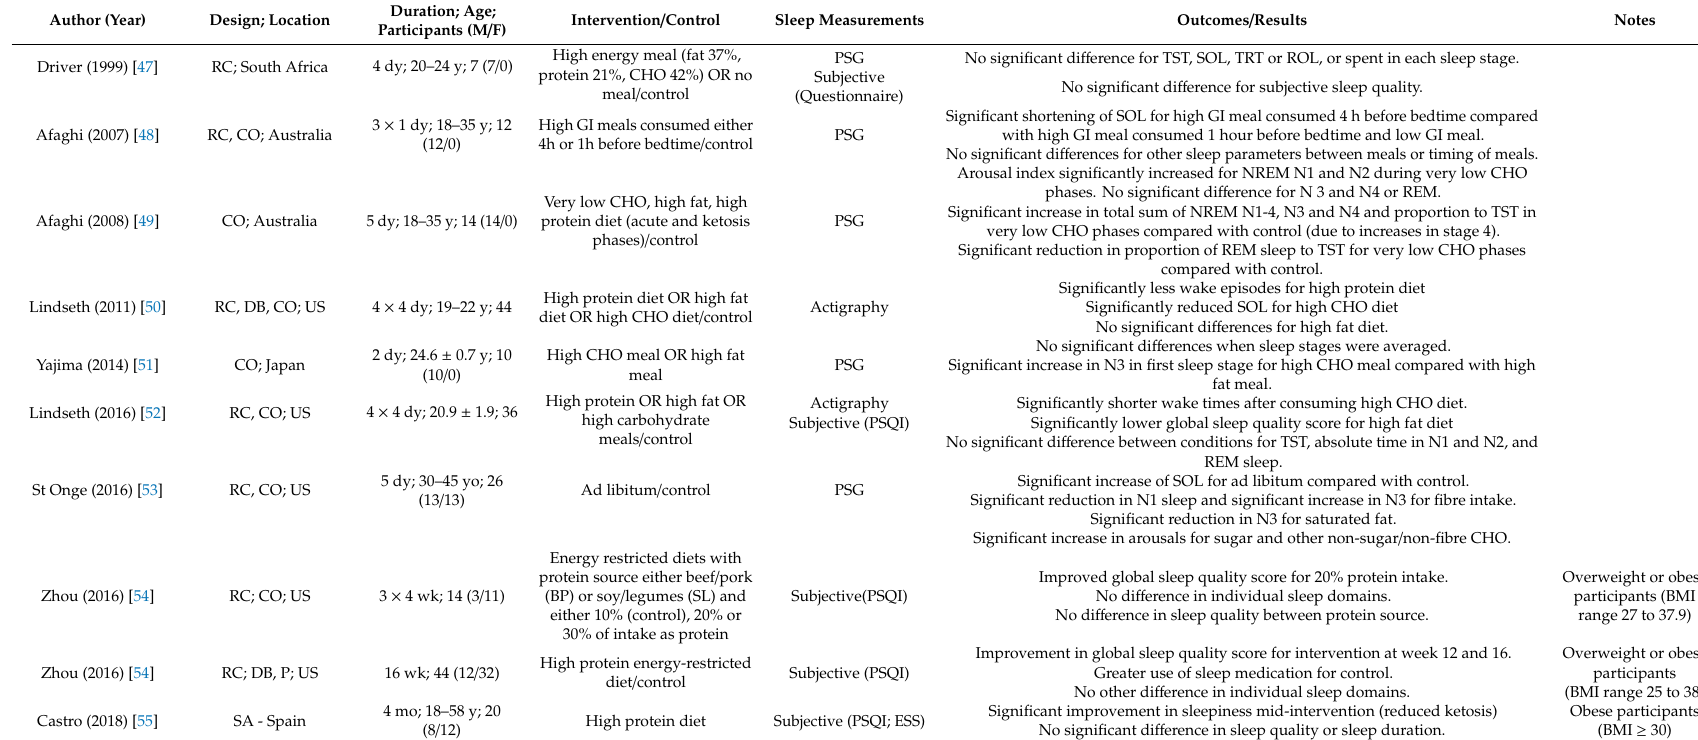
Table 4. The study characteristics and outcomes for the investigations between macronutrients and